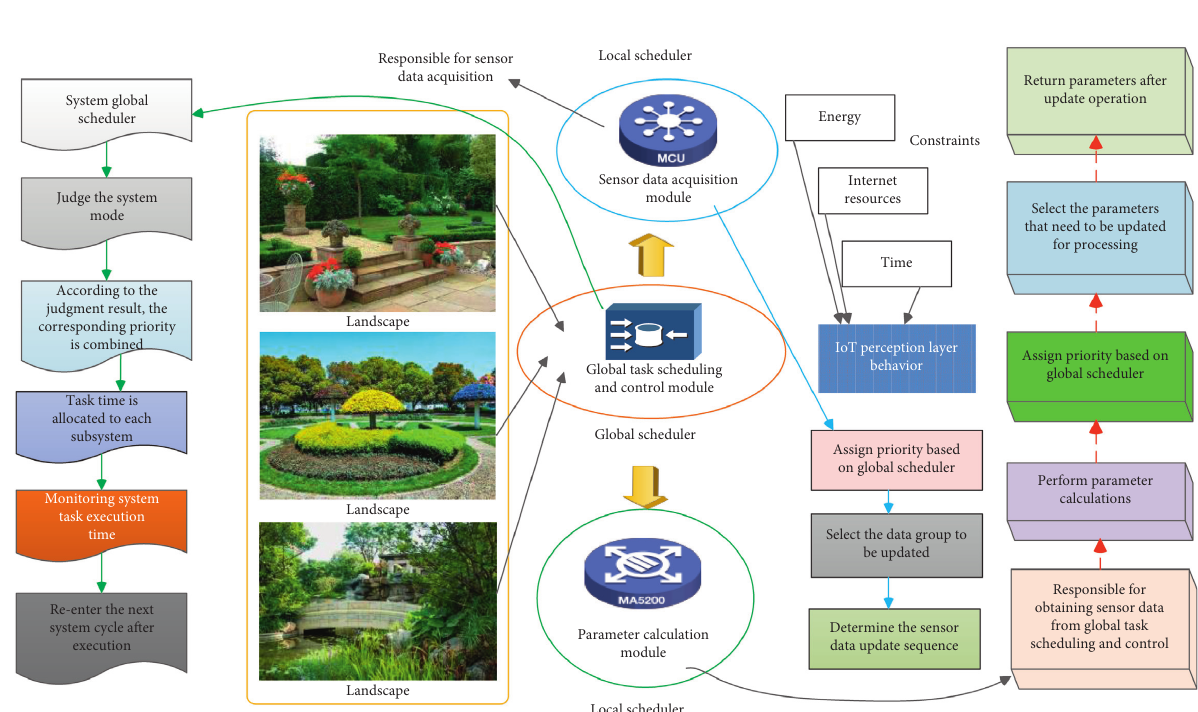
Figure 2: Hierarchical scheduling model of high-density three-dimensional Internet of Things landscape perception layer information acquisition system.